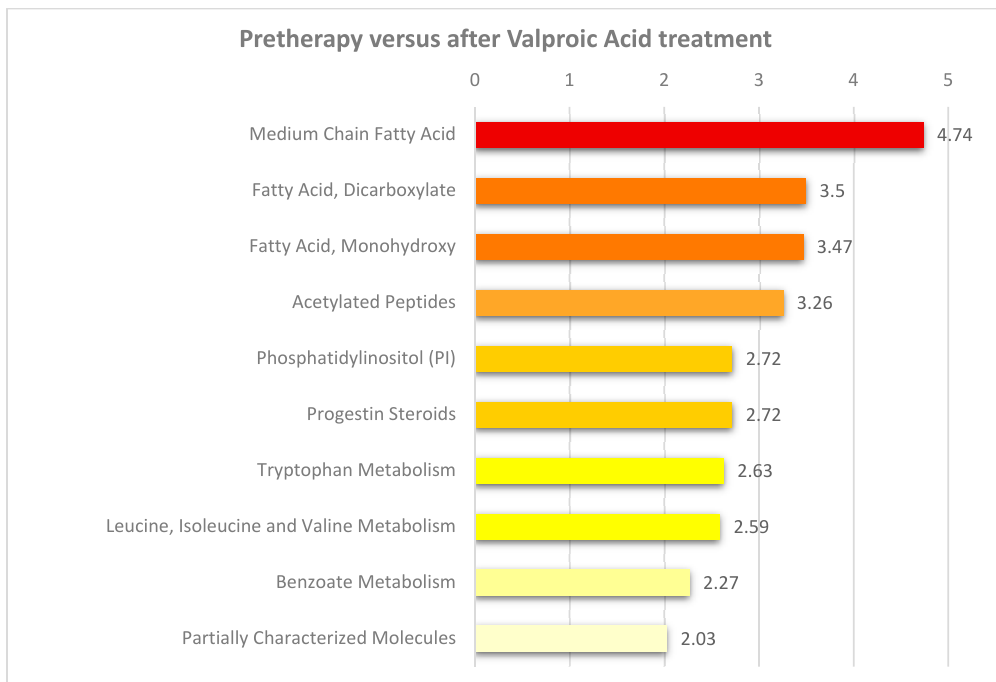
Figure 7. Pathway enrichment analysis based on metabolites altered after seven days of valproic acid treatment compared to pretherapy levels. This analysis was based on significant altered metabolites p < 0.05 (see Figure S5), and only pathways with an enrichment value greater than two and at least two metabolites within each pathway are shown. The most significant pathway is shown in red and less significant pathways in light yellow.